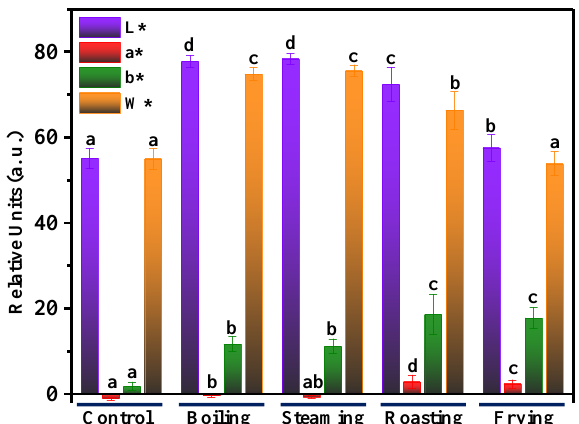
Figure 4. Lightness (L*), redness (a*), yellowness (b*) and whiteness (W*) of fish samples before (control) and after treatment of boiling, steaming, roasting and frying. Different letters indicate significant differences between groups ( p < 0.05).